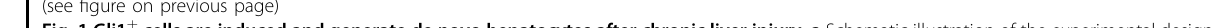
Fig. 1 Gli1 + cells are induced and generate de novo hepatocytes after chronic liver injury. a Schematic illustration of the experimental design. b Representative histological images of X-gal-stained liver sections from Gli1-LacZ mice after 4 weeks of a normal diet or DDC diet (left panel). Quanti fi cation of the number of X-gal + cells after injury (right panel). Data are shown as means ± SEM ( n = 3). ** P < 0.01. c Representative immuno fl uorescence staining of liver sections from mice that received a normal or DDC diet using antibodies against β -gal (green) and PDGFR α (red), HNF4 α (red), or KRT19 (red). PV portal vein. Scale bars, 50 μ m. Right panels: quanti fi cation of the percentage of β -gal + cells expressing HNF4 α , KRT19 and PDGFR α . Data are represented as means ± SEM ( n = 5). N.D not detected. d Schematic representation of lineage tracing using Gli1- Cre ERt2 ;Ai9 reporter mice after DDC-induced liver injury. e Schematic illustration of the experimental design. f Schematic diagram of the protocol for clearing the liver from Gli1-Cre ERt2 ;Ai9 mice after 4 weeks of a normal diet or DDC diet with CUBIC. g Reconstructed 3D images of the livers of Gli1- Cre ERt2 ;Ai9 mice after 4 weeks of a normal diet or DDC diet. Images were obtained by light-sheet fl uorescence microscopy (LSFM) ( z -stack: 5 μ m/slice). White arrowheads indicate hepatocyte morphology. Scale bars, 200 μ m. h Immunostaining for tdTomato (red) and KRT19 (green), EpCAM (green) or HNF4 α (green) in tissue sections from livers after Gli1-Cre ERt2 ;Ai9 mice received a DDC diet for 4 weeks. Scale bars, 50 μ m. White arrowheads indicate hepatocyte morphology. White arrow indicates EpCAM + tdtomato + cells. Right panels: quanti fi cation of the percentage of tdTomato + cells expressing HNF4 α , KRT19 and EpCAM. Data are shown as means ± SEM ( n = 5). N.D not detected. * P < 0.05. i Immunostaining for tdTomato (red) and HNF4 α (green) in tissue sections from livers after Gli1-Cre ERt2 ;Ai9 mice received an MCD diet for 4 weeks. White arrowhead indicates hepatocyte morphology. Scale bar, 50 μ m. j Immunostaining for tdTomato (red) and HNF4 α (green) in tissue sections from livers after Gli1-Cre ERt2 ;Ai9 mice received a CDE diet for 4 weeks. White arrowheads indicate hepatocyte morphology. Scale bar, 10 μ m. k Immunostaining for tdTomato (red), Ki67 (white) and KRT19 (green), EpCAM (green), HNF4 α (green) or PDGFR α (green) within representative liver sections at 4 weeks after DDC-induced injury. White arrowheads indicate hepatocyte morphology. White arrow indicates EpCAM + tdtomato + cells. Scale bars, 50 μ m. Right panels: quanti fi cation of the percentage of tdTomato + , KRT19 + , EpCAM + , HNF4 α + , or PDGFR α + cells expressing Ki67. N.D, not detected. Data are shown as means ± SEM ( n =